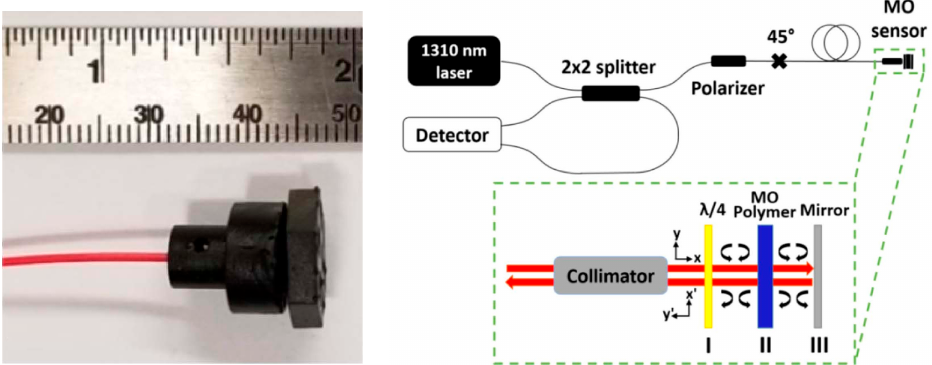
Figure 2. Magnetic field sensor prototype based on nanocomposite polymers and the sensing system [22] (Copyright © 2018 OSA, Reprinted with permission).